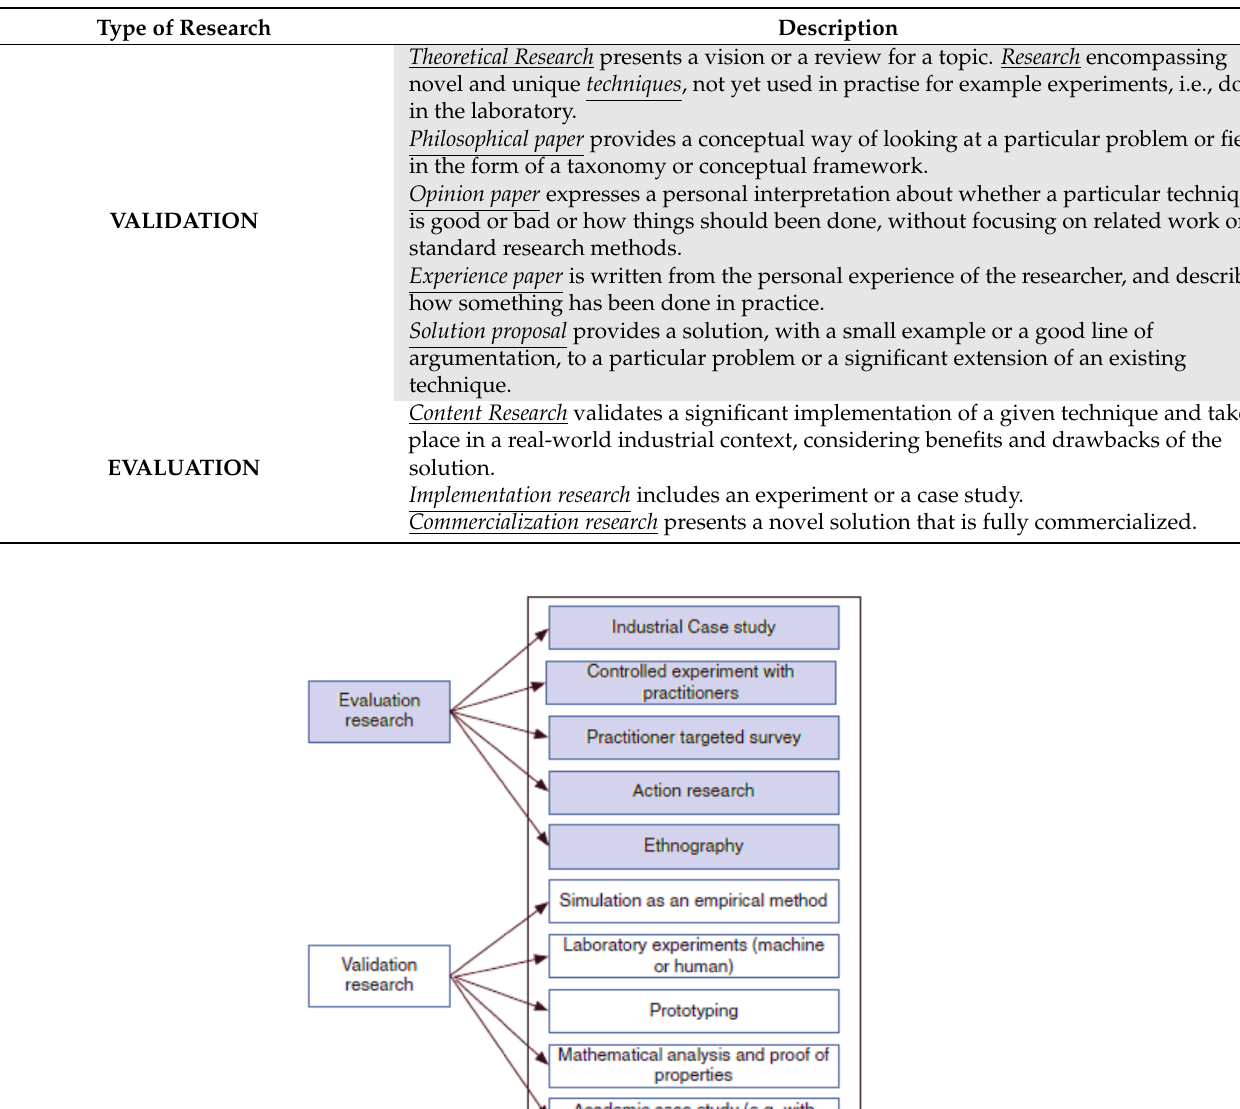
Table 3. Type of research included.